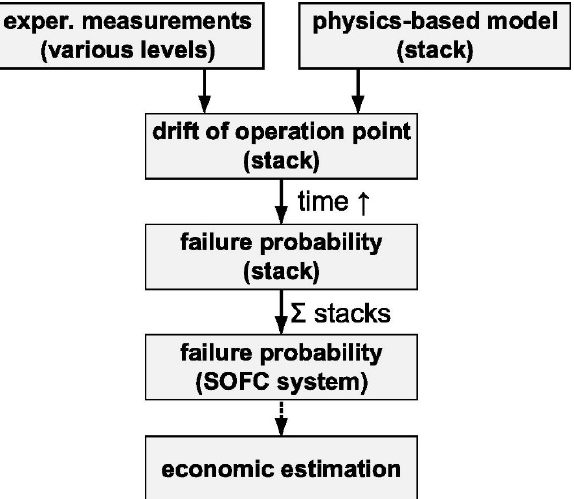
Figure 9. Block diagram for the development of failure models. Reprinted with permission from Ref. [43]. Copyright 2021, Elsevier.